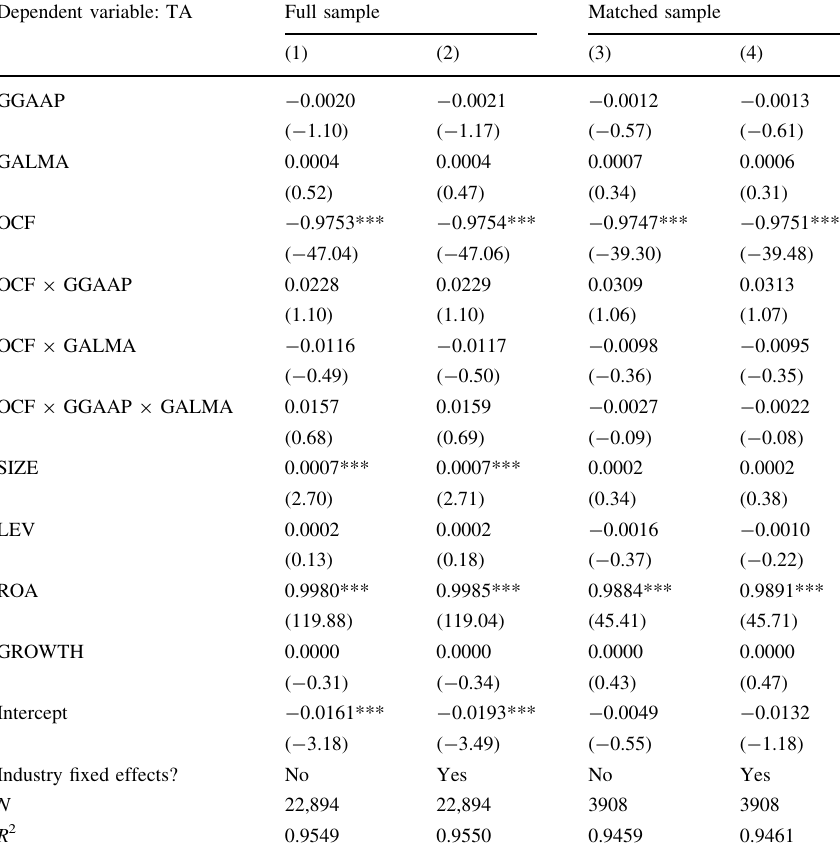
Table 8 Second financial reporting property: correlation between accruals and operating cash flow Dependent variable: